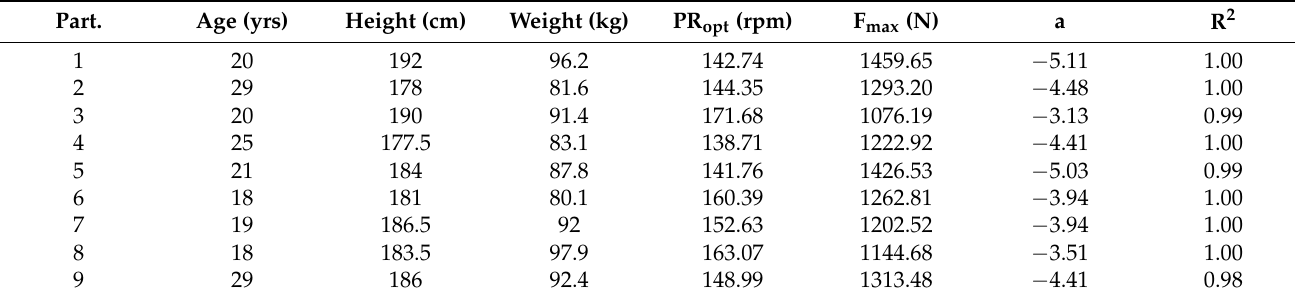
Table 1. Anthropometric data and model parameters of the linear fatigue-free F/v profile with corresponding model quality R 2 of all participants. Part.